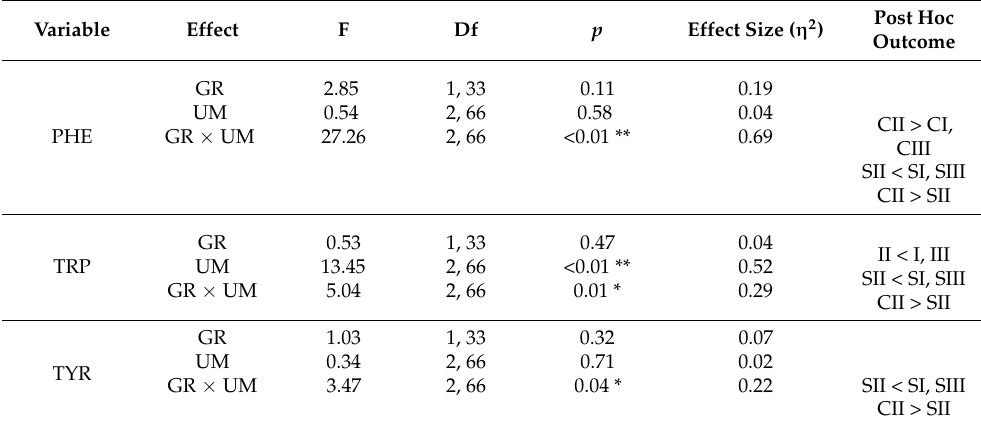
Table 2. Two-way ANOVA (2 groups × 3 repeated measures) of changes in serum levels of pheny- lalanine (PHE), tryptophan (TRP), and tyrosine (TYR) induced by ultramarathon run. Variable